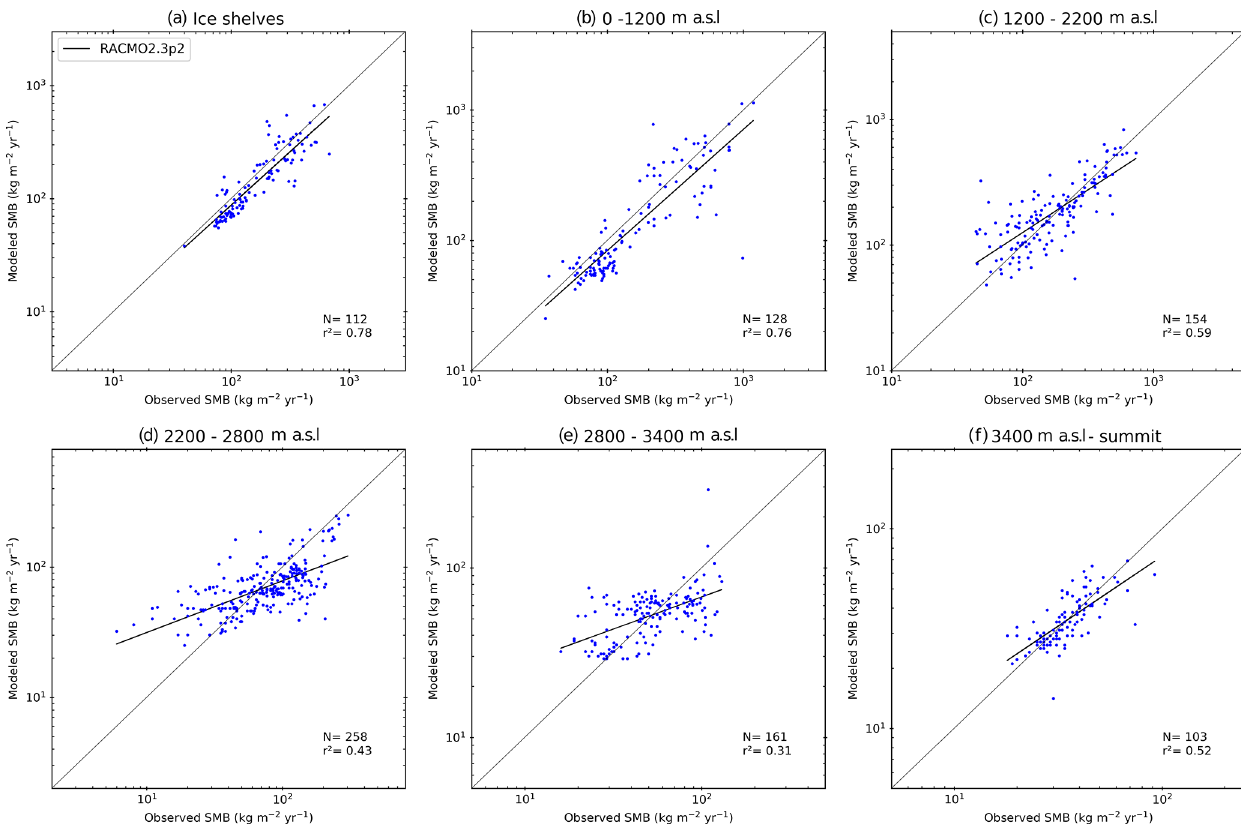
Figure A8. Comparison between RACMO2.3p2 and observed SMB (units: kgm − 2 yr − 1 ) over the ice shelves (a) and by elevation classes (b– f) . Due to the use of logarithmic axes, only positive values for the observed and modelled SMB from all the RCMs in this study are used (number for each bin N ). Finally, the regression coefficient of each regression line is also shown ( r 2 ).